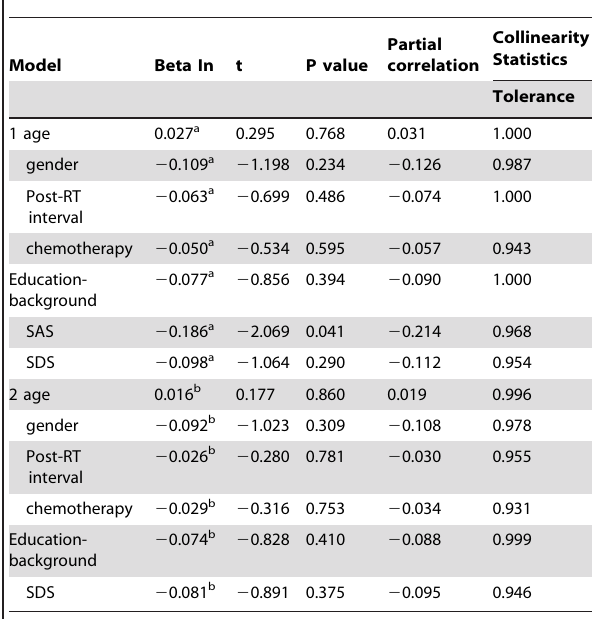
Table 8. Excluded variables b